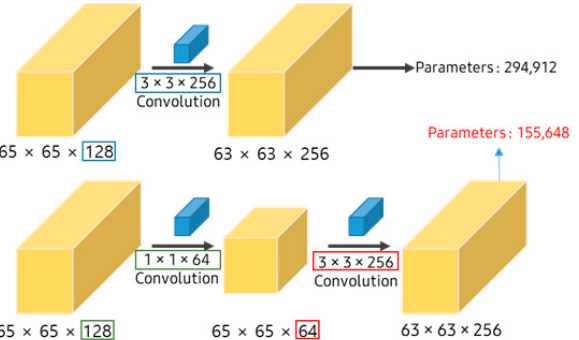
Figure 3. Comparison of the No. of Parameters in a Convolution Layer; Above: Standard convolution, Below: Bottleneck structured convolution.